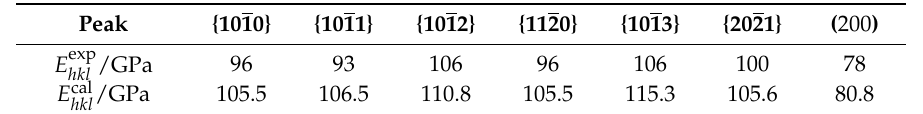
Table 4. The calculated results and experimental values of the crystal plane diffraction elastic constants for Ti6Al4V (TC4). Peak {1010}